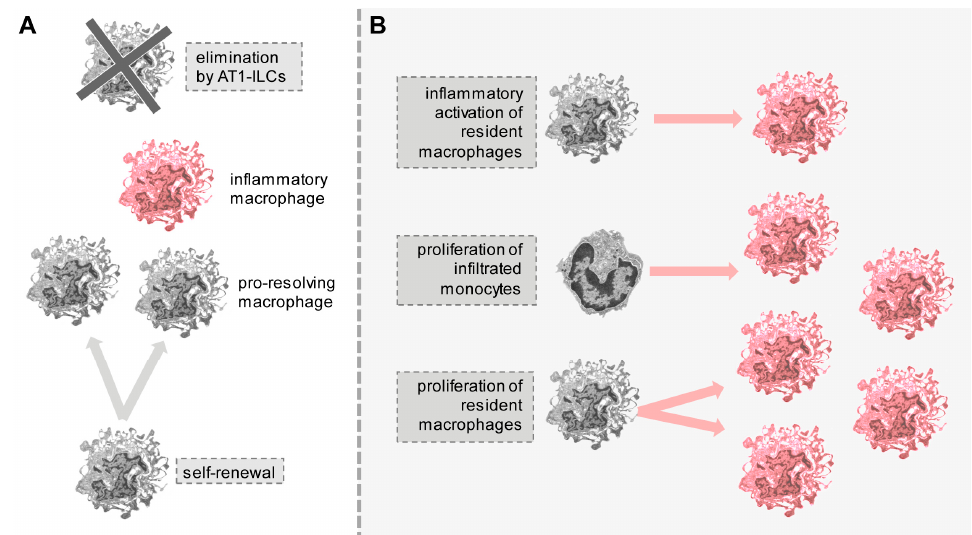
Figure 1. Self-renewing macrophages are key for organ development and function. ( A ) Transmission electron microscopy images of macrophages in the cell cycle. cp: cytoplasm, nu: nucleus, ch: chromosomes, scale bar 10 μ m; ( B ) Summary of developmental, repair, metabolic, and immune functions that are dependent on self-renewing macrophages.